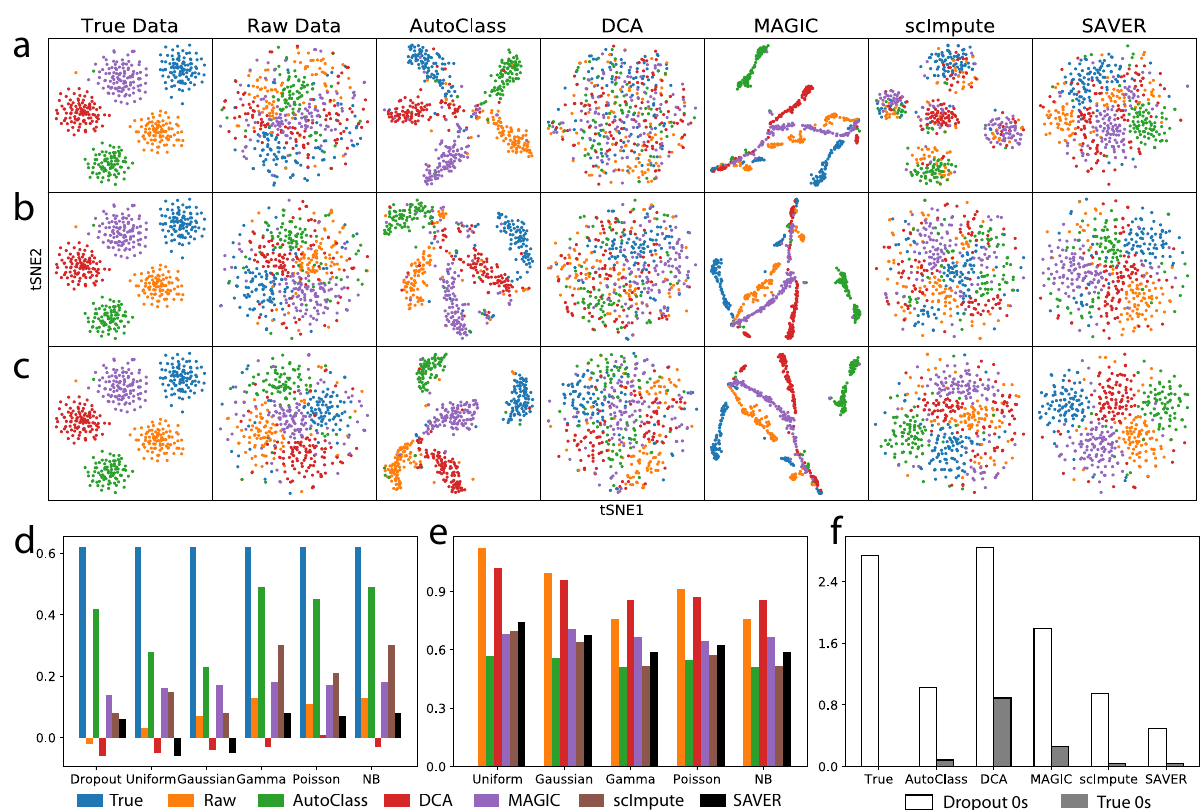
Fig. 2 Gene expression data recovery after imputation. a – c t-SNE plots for Dataset 2 (dropout noise), Dataset 4 (Gaussian noise) and Dataset 7 (negative binomial noise), respectively. d Average Silhouette width based on t-SNE plot for Dataset 2-7. e Mean squared error between true data and imputed data for Dataset 3-7. f Average recovered values of dropout 0 s and true 0 s for different imputation